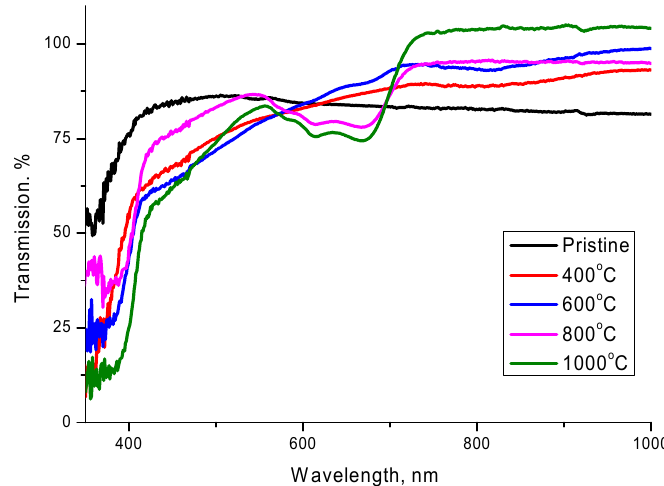
Figure 5. UV-Vis transmission spectra of synthesized ceramics depending on the change in annealing